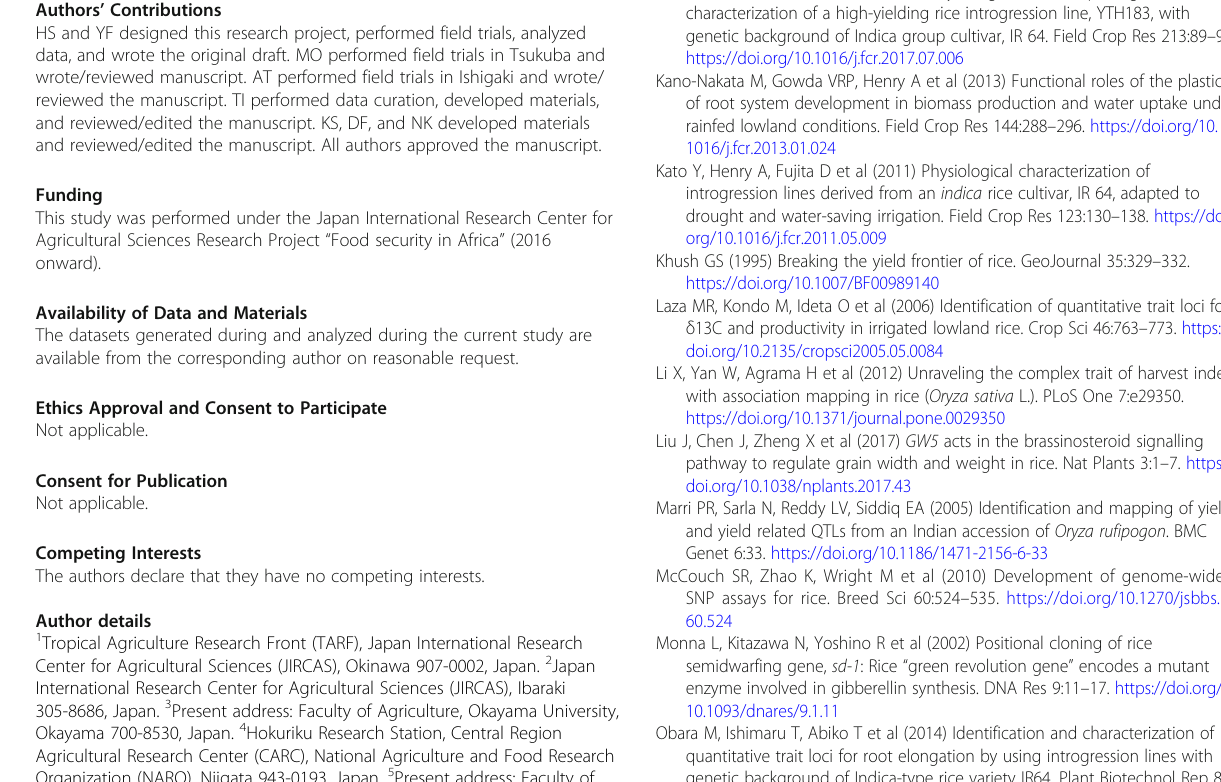
Additional file 1: Figure S1. Details of two major QTLs for HI. (a) qHI5.1 and (b) qHI8.1 . The GSE5/GW5 gene is closely linked with RM1089. The dotted lines on the LOD value curves indicate a threshold calculated by a 1000-times permutation test (the value is 2.41). Figure S2. Identification of genomic polymorphism between IR 64 and YTH183. (a) Schematic image of LOC_Os05g09520. The white boxes, black triangle, and black bar indicate, respectively, the exon region, insertion position, and 1 Kbp scale bar. The two arrows indicate the primer positions, whose sequences are as follows: Forward primer: TCCATTTTATTGGCATCACTCA; Reverse pri- mer: CCCAAATCCCAGGCTACTGAT (from Duan et al. 2017). (b) Electro- phoresis image of the amplicons. M: 100bp ladder. Figure S3. Graphical genotypes of YTH183. The open and closed bar represent genotypes at regions corresponding to the IR64 homozygous segment and the YP5 homozygous segment, respectively. The top numbers indicate the chromosome number. Figure S4. 1000-grain weight of IR64, YTH183, and the sib lines derived from the same parent (YP5) as YTH183 (Fujita et al. 2009) at Tsukuba in 2015. The black and white bars indicate the IR64-type and YTH183-type alleles at the GSE5/GW5 locus, respectively. The P value indicates the statistical analysis by Student ’ s t-test. Table S1. Heading date of IR 64 and YTH183. Table S2. The harvest index of IR 64, YTH183, and their derived RIL population. Table S3. Average daily temperature during the maturing